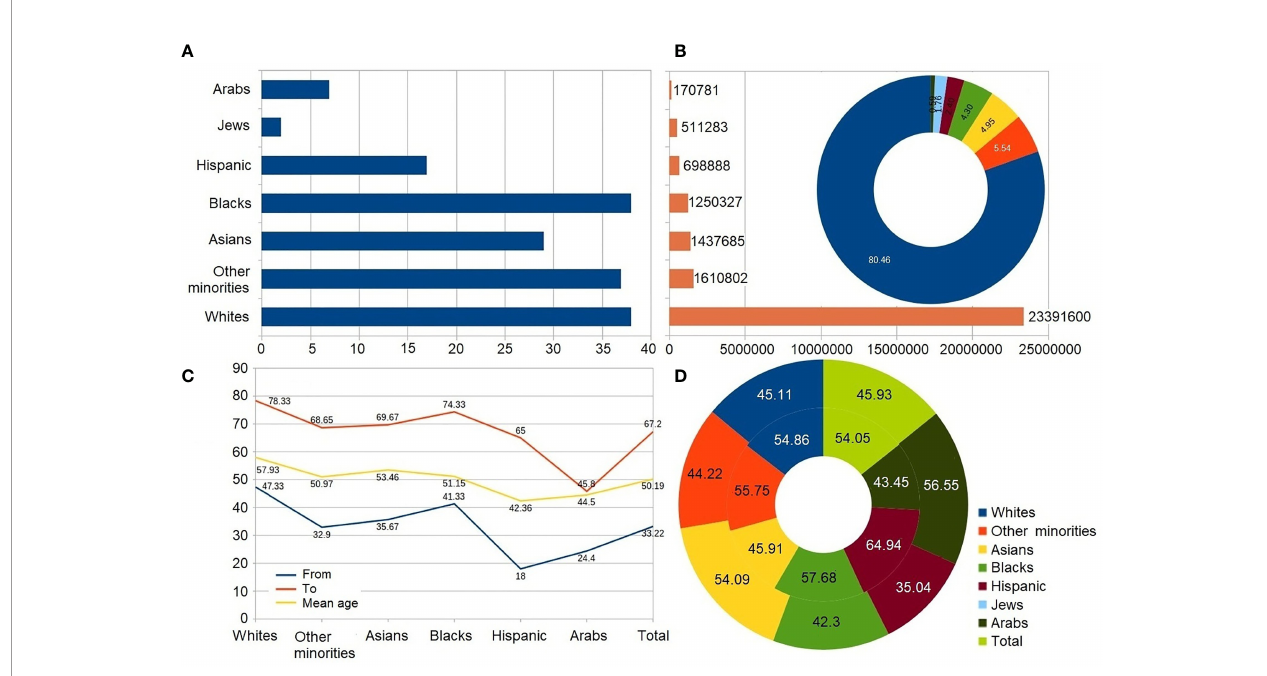
FIGURE 2 | Analysis of the ethnicity-based research papers. Circle diagrams report data in percentages. Results are calculated as average value of data reported in papers. (A) Number of papers. (B) Size of study cohort; circle diagram represents percentage out of all studied population. (C) Average age of participants. (D) Gender distribution. External/internal circle represents male/female